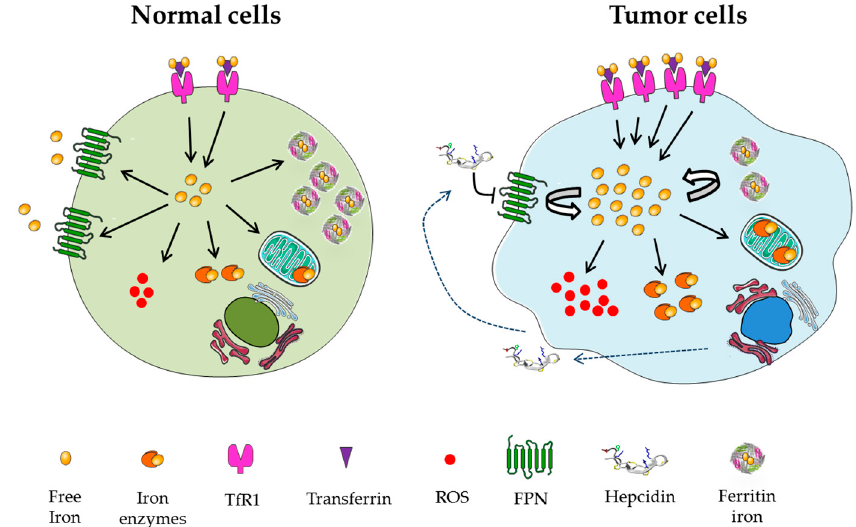
Figure 2. Iron addiction of tumor cells. In normal cells the transferrin receptor 1 (TfR1)-mediated iron absorption is counter balanced by iron efflux via ferroportin (FPN); the free iron pool is used by cytosolic and mitochondrial enzymes and the excess is stored by ferritins to prevent cytotoxicity. As a result, only a minor part of the intracellular iron, present as a free labile pool, can stimulate the formation of Reactive Oxygen Species ROS. In contrast, tumor cells often show higher levels of TfR1, down-regulation of FPN mediated by secreted hepcidin and lower levels of ferritins, which leads to an increased intracellular labile iron pool; despite this it’s mostly being utilized for tumor growth by cytosolic and mitochondrial iron enzymes, the exceeding amount can promote increased oxidative stress via ROS accumulation. The figure was adapted using a template on the servier medical art